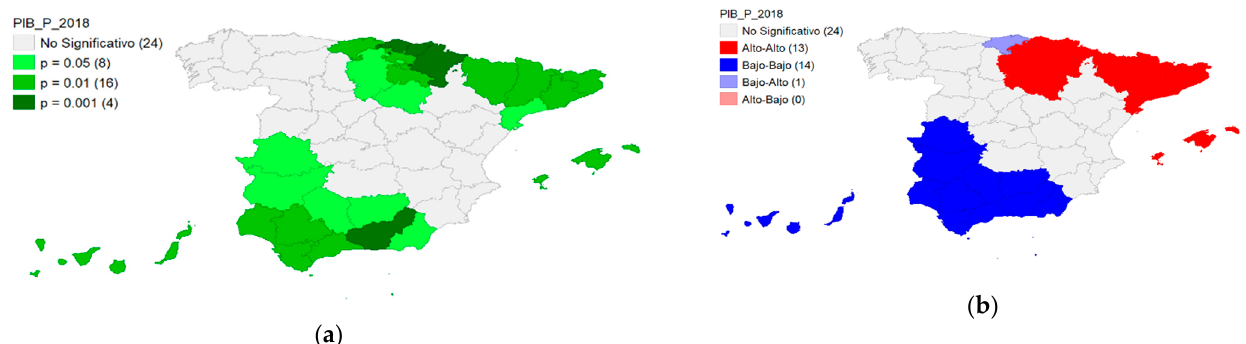
Figure 6. Significance map ( a ) and clusters map ( b ) for GDP per capita.